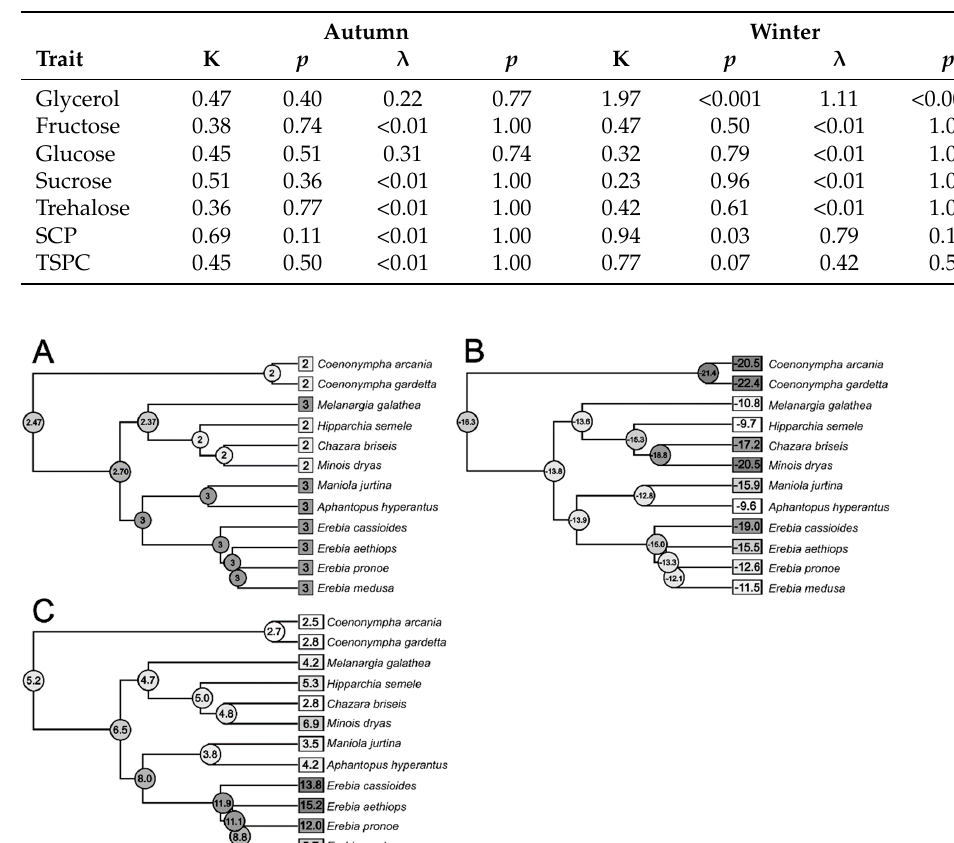
Figure 4. Phylogenetic trees with mapped ancestral states of ( A ) Winter glycerol (log μ g/g), ( B ) average supercooling points (SCP, °C), and ( C ) Winter total sugar and polyol concentrations (TSPC, μ g × mg − 1 ) in larvae of selected European Satyrinae. Measured values are depicted on branch tips, and ancestral states, inferred by the phylogenetically independent contrasts, are shown on each node of the tree. For tree inference, see Appendix A.